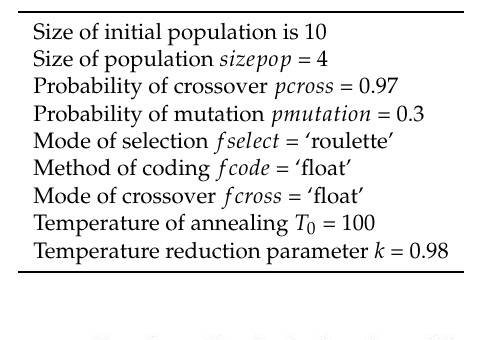
Table 1. Experiment parameters.